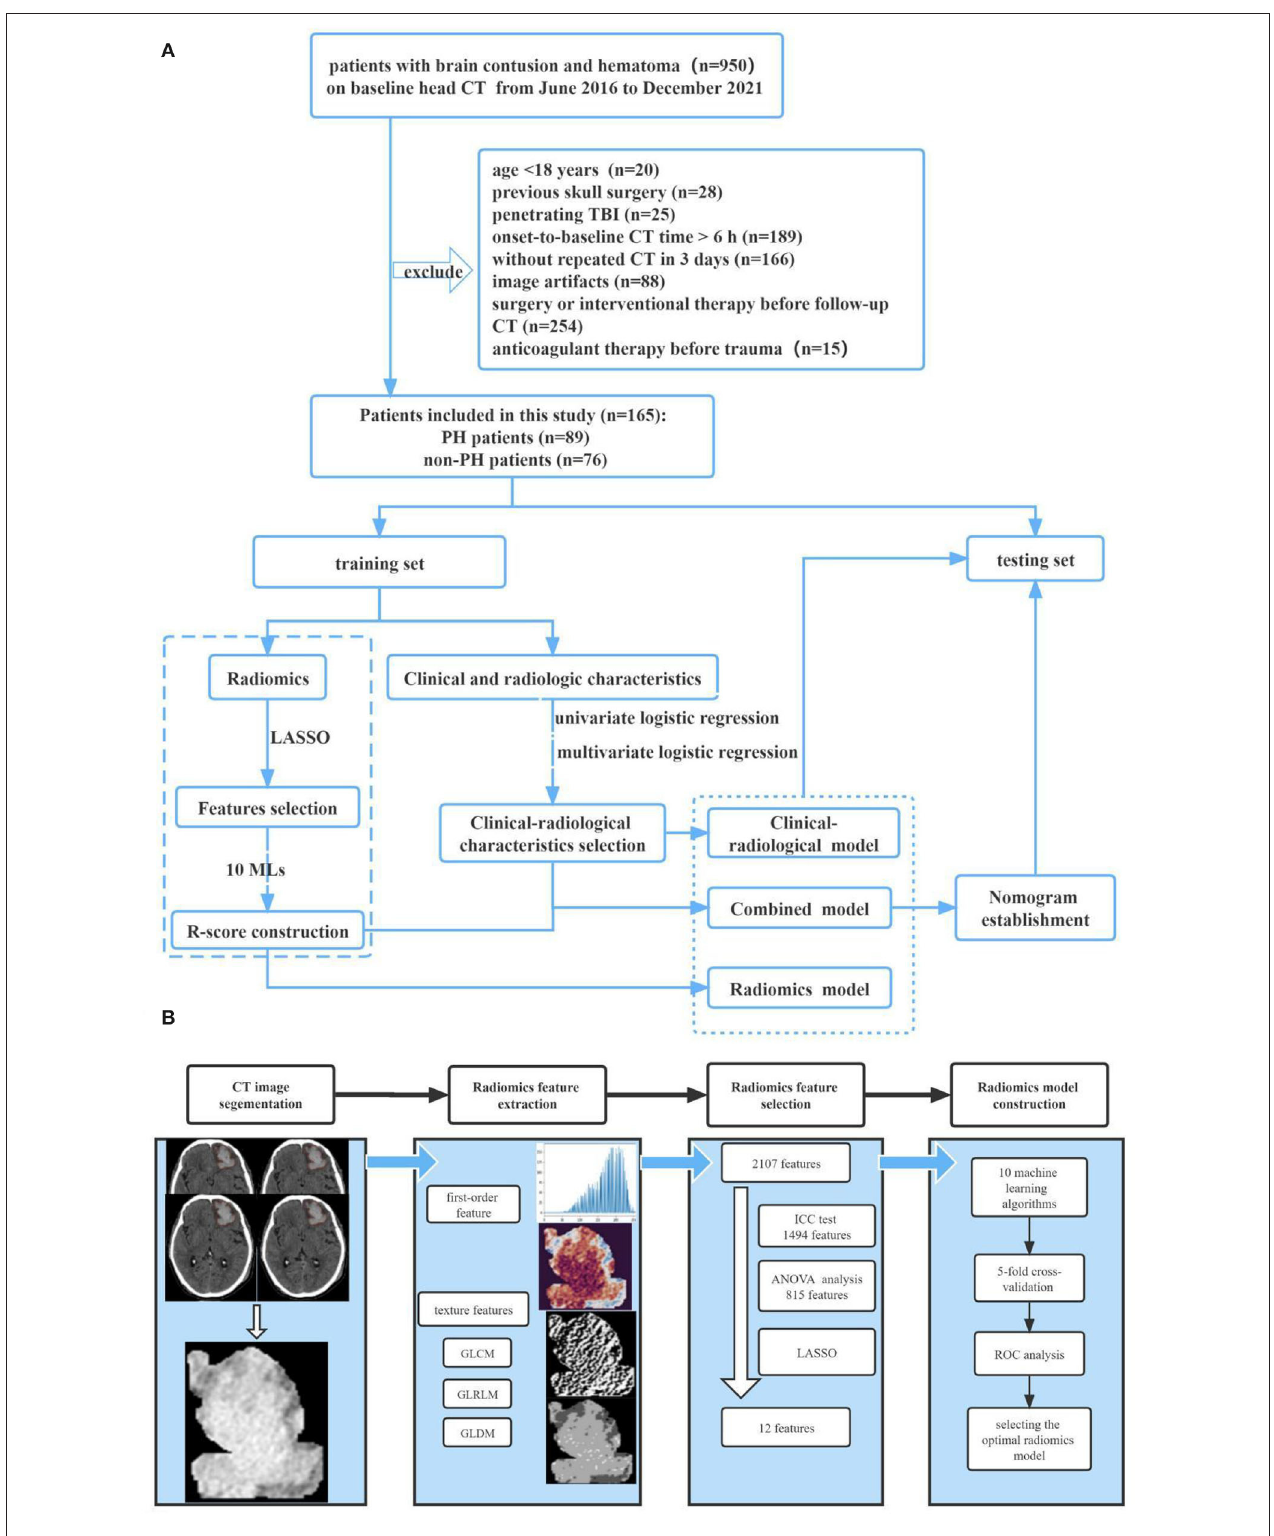
FIGURE 1 | Study overview. (A) Workflow of the study. (B) Workflow of the radiomics analysis.